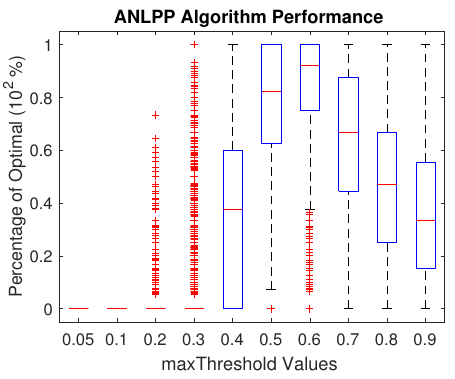
Figure 6. The impact of maxThreshold on the performance of All Network Least Possible Probability